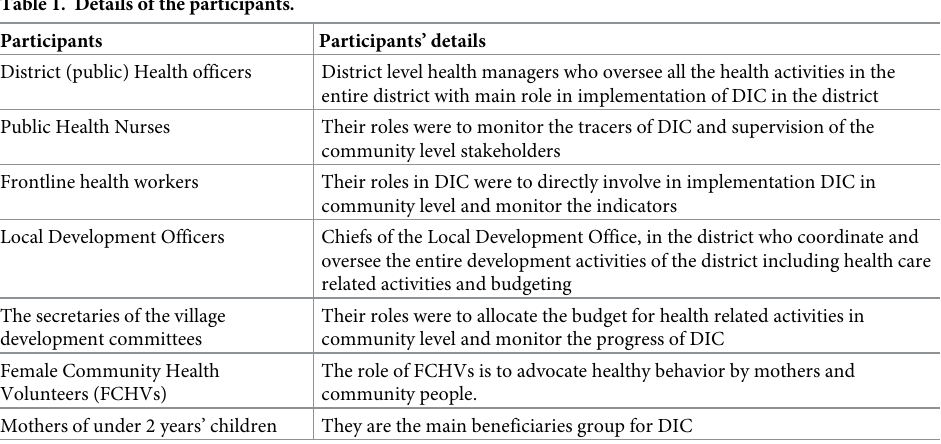
Table 1. Details of the